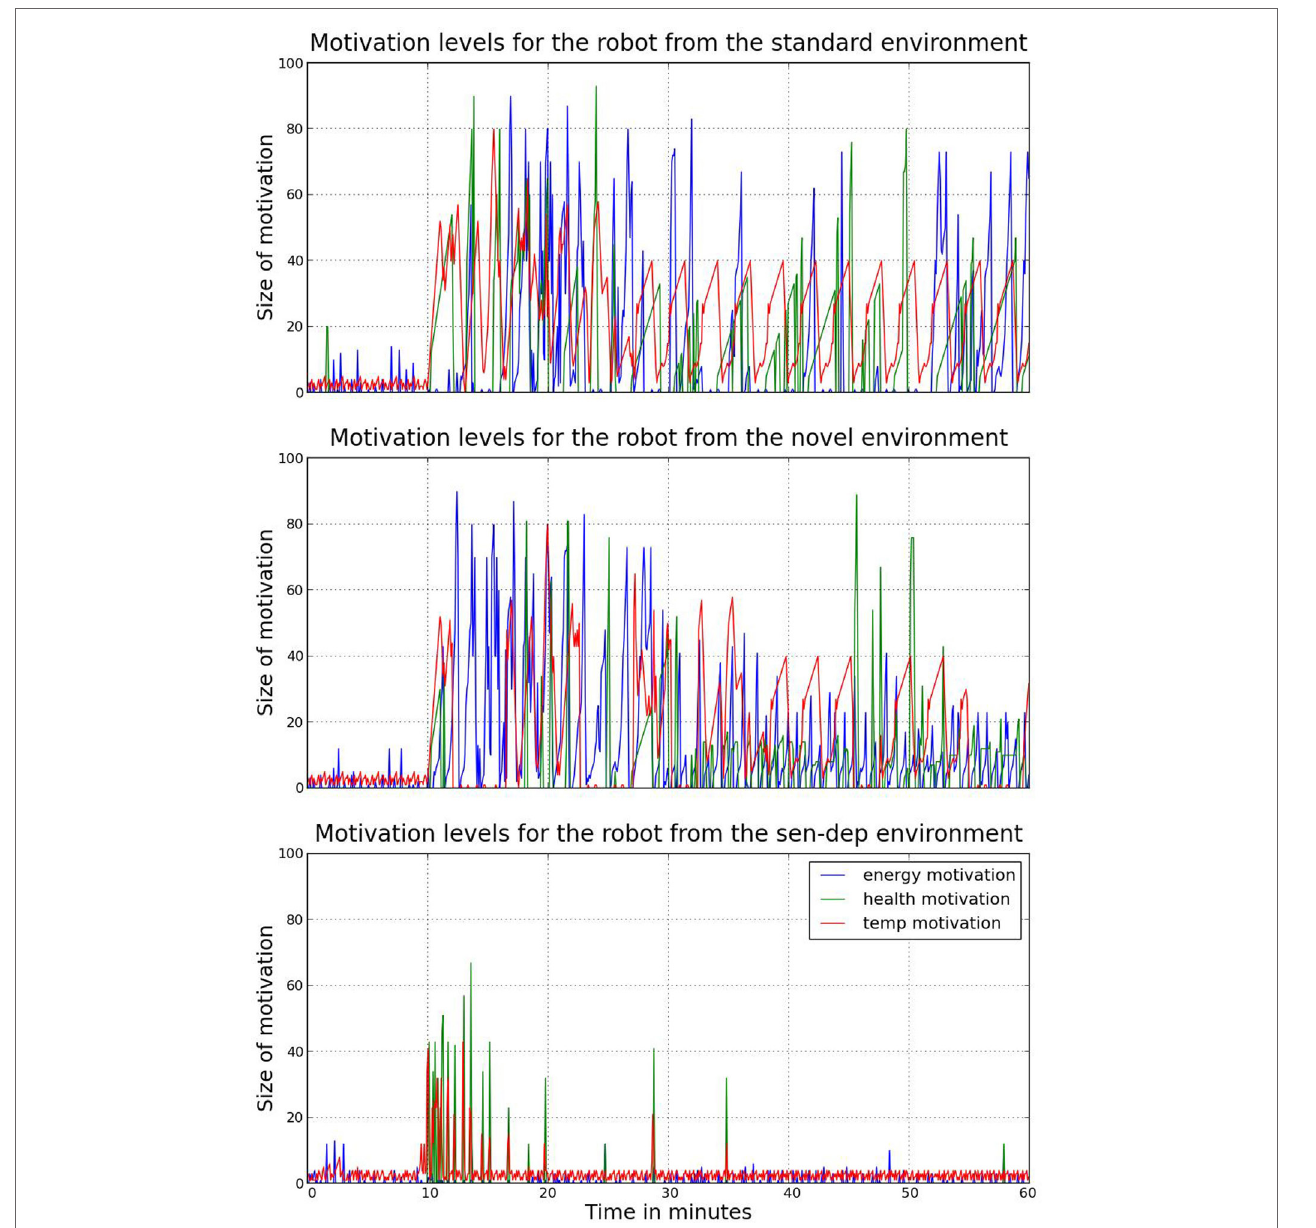
FigUre 7 | a comparison of the three main motivations (replenishment of a homeostatic variable) for each robot during the experiments . As can be seen, during the period immediately following the initial ten minutes with the caregiver, changes and growth of motivations are much more volatile. This leads to increased occurrences of rapid behavior switching. Due to the volatility of change, this can lead to both inefficiencies and missed opportunities, i.e., constantly moving between two resources without (fully)